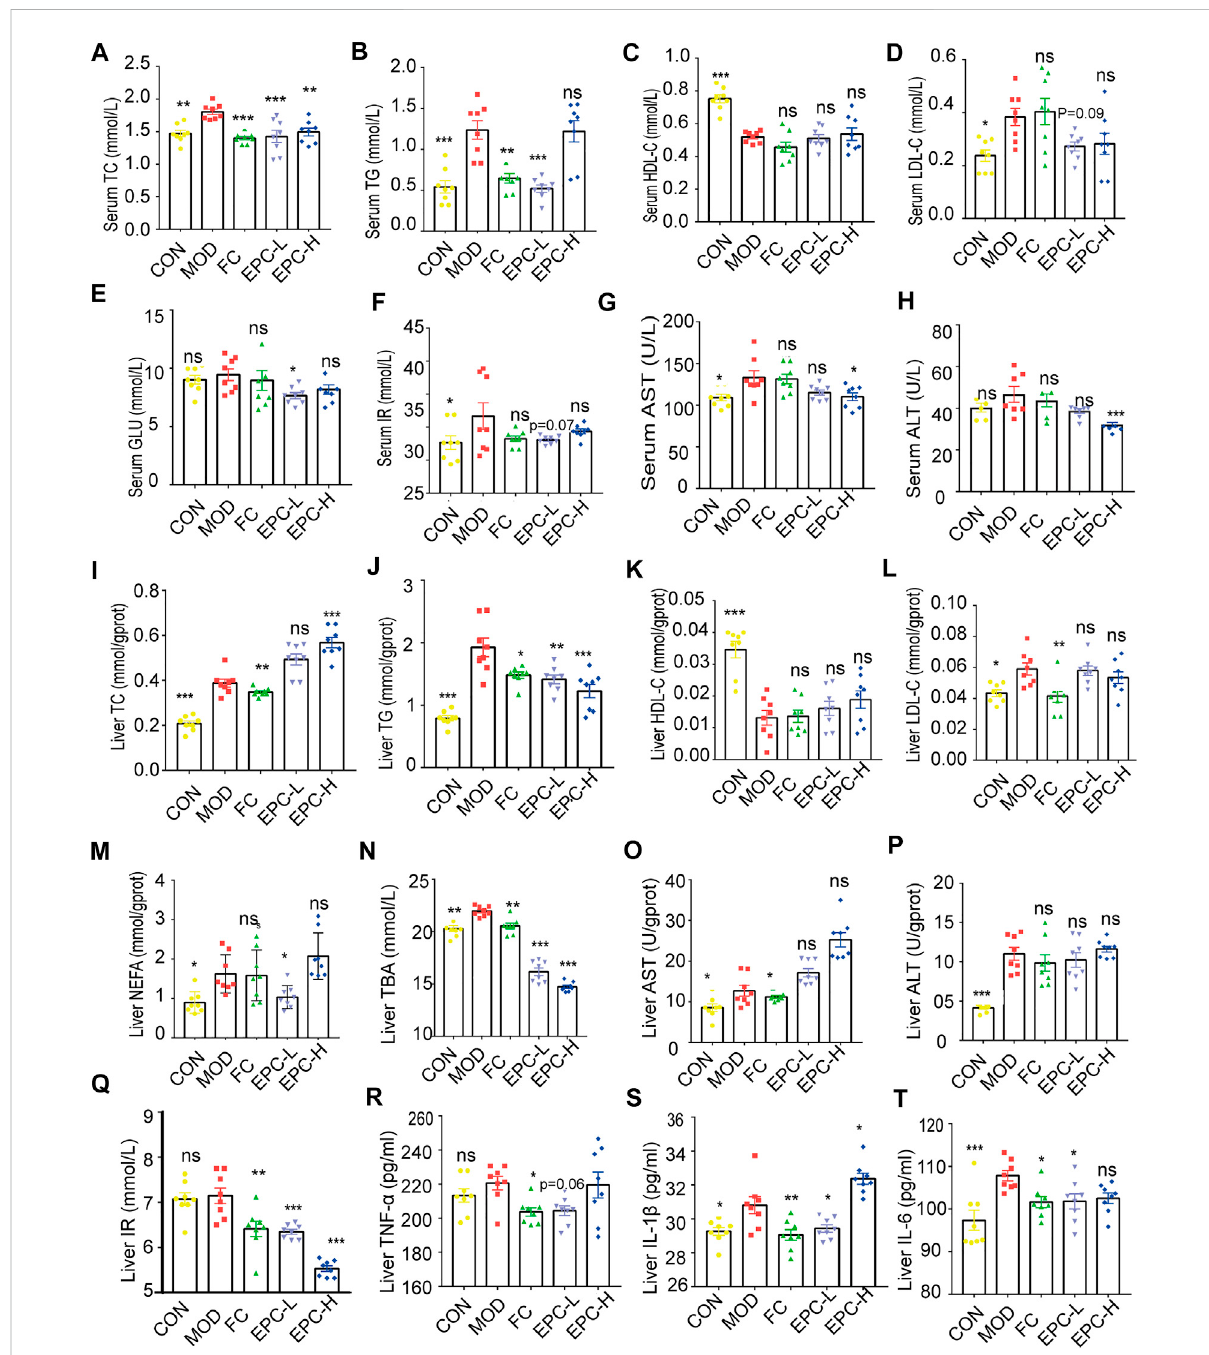
EPC administration improved lipid metabolism in HFD-fed rats. (A – H) Serum concentrations of TC, TG, HDL, LDL, GLU, IR, AST, and ALT in the rat. (I – T) Liver concentrations of TC, TG, HDL, LDL, NEFA, TBA, AST, ALT, IR, TNF- α , IL-1 β , and IL-6. One-way analysis of variance (ANOVA) was conducted for the group comparison. n = 8, data are presented as mean ± SEM. * p < 0.05, ** p < 0.01, *** p < 0.001 vs MOD group. TC, cholesterol; TG, triglyceride; BA, bile acid; TBA, total bile acid; NEFA, nonesteri fi ed free fatty acids; ALT, alanine transaminase; AST, aspartate transaminase; NEFA, nonesteri fi ed freefatty acid; LDL-C, low-density lipoprotein cholesterol; HDL-C, high-density lipoprotein cholesterol;TNF- α , tumor necrosis factor- α ; IL-1 β , Interleukin -1 β ; IL-6, Interleukin -6; IR, Insulin Receptor; GLU,